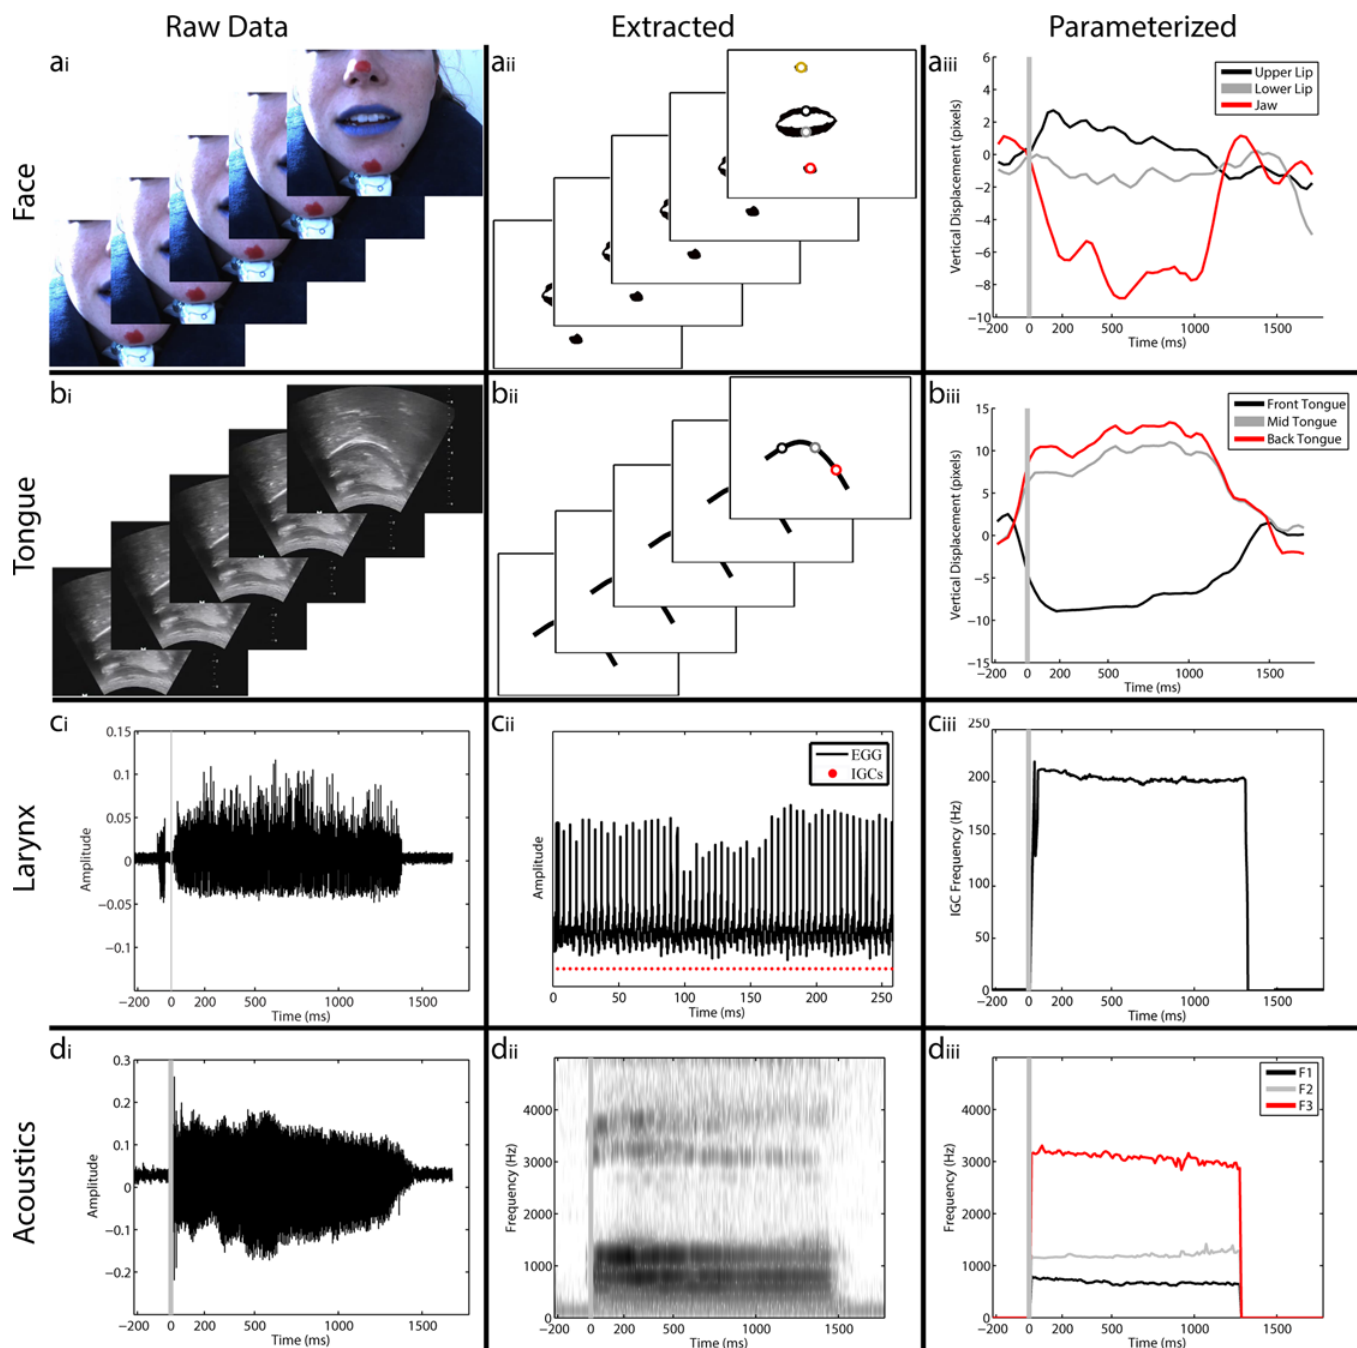
Fig 1. Data processing steps for facial, lingual, laryngeal, and acoustic data. a) The lips of the speaker were painted in blue and dots were painted in red on the nose and chin. A camera was then placed in front of the speaker ’ s face such that all painted regions were contained within the frame and the lips are approximately centered. Video was captured at 30 frames per second (fps) during speaking (i). Each frame of the video was thresholded based on hue value, resulting in a binary mask. Points were defined based upon the upper, lower, left and right extents of the lip mask and the centroids of the nose and jaw masks (ii). The X and Y position of these points was extracted as a time varying signal (iii). Grey lines mark the acoustic onset. b) The tongue was monitored using an ultrasound transducer held firmly under the speaker ’ s chin such that the tongue is centered in the frame of the ultrasound image. Video output of the ultrasound was captured at 30 fps (i). The tongue contour for each frame was extracted using EdgeTrak, resulting in an X and Y position of 100 evenly placed points along the tongue surface (ii). From these 100 points, three equidistant points were extracted, representing the front, middle, and back tongue regions which comprises our time varying signal (iii). c) Instances of glottal closure were measured using an electroglottograph placed with contacts on either side of